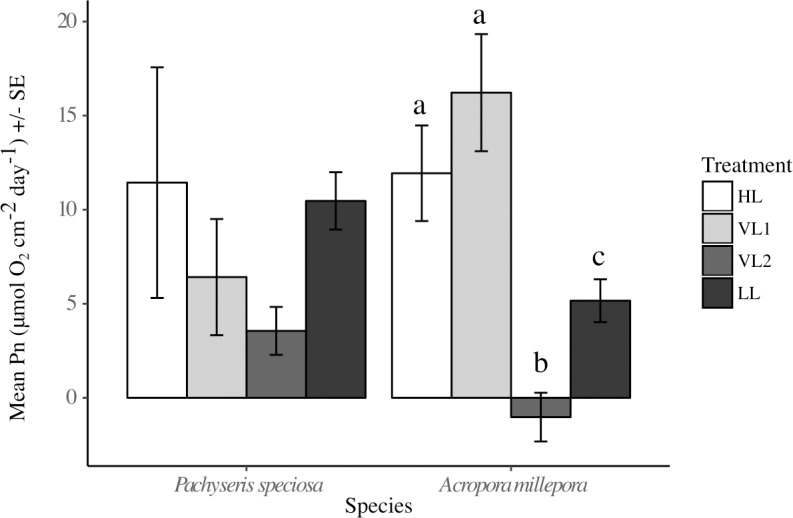
Effects of constant versus variable light on daily net oxygen production.Net daily production, Pn (μmol O2 cm-2 d-1), for Pachyseris speciosa and Acropora millepora in high DLI (HL, white), low DLI (LL, black), variable DLI treatment ending in high-light (VL1, light gray) and variable DLI treatment ending in low-light (VL2, dark gray) derived from P-I curves. Error bars represent standard error, N = 2-3/treatment/species.